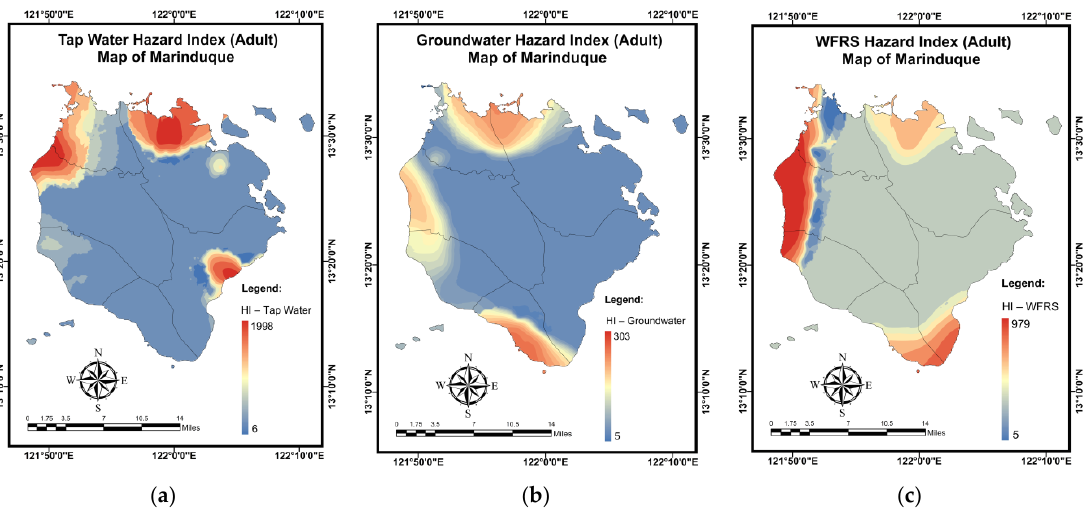
Figure 16. Spatial maps of HI (adults) developed using MLGI approach for ( a ) TW samples, ( b ) GW samples, and ( c ) WRS samples.